Question: What form of chart is displayed?
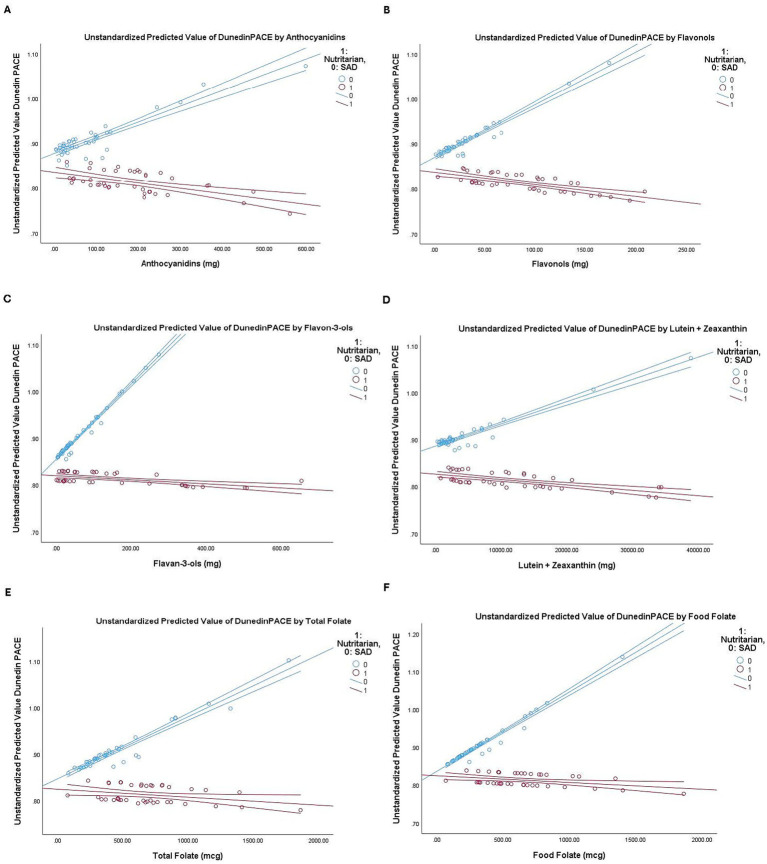
Answer: scatter